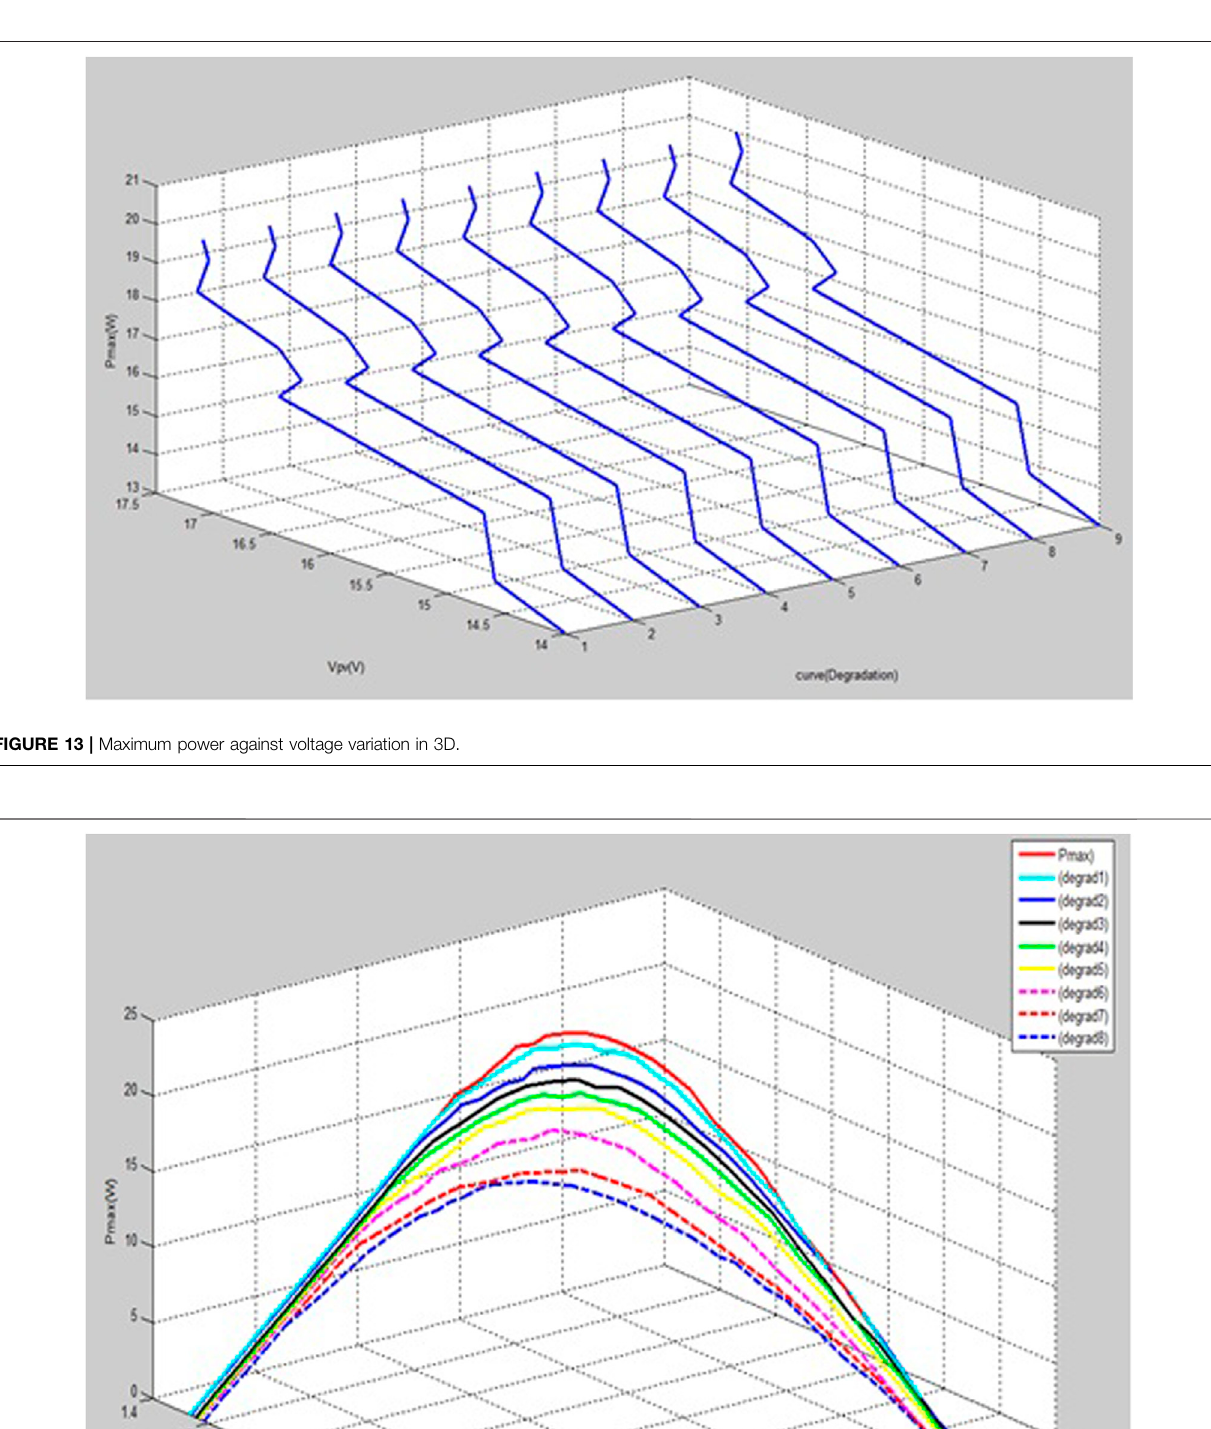
Frontiers in Energy Research |